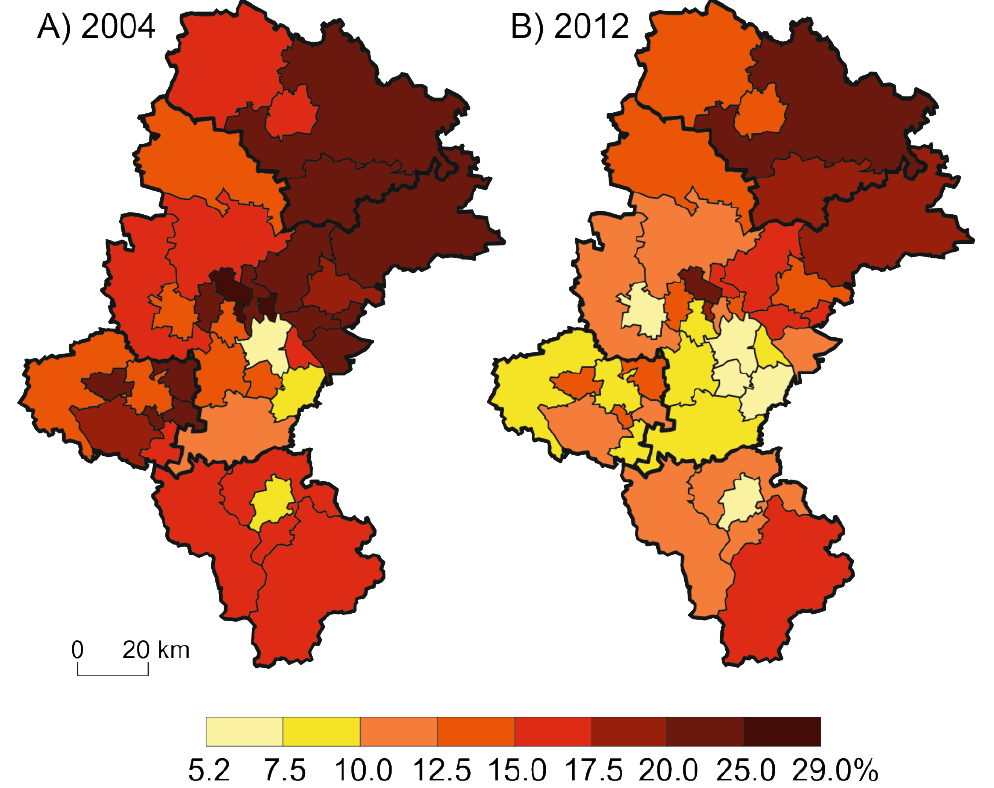
Fig. 5. Registered unemployment rate in 2004 and 2012 (after Sitek et al.,